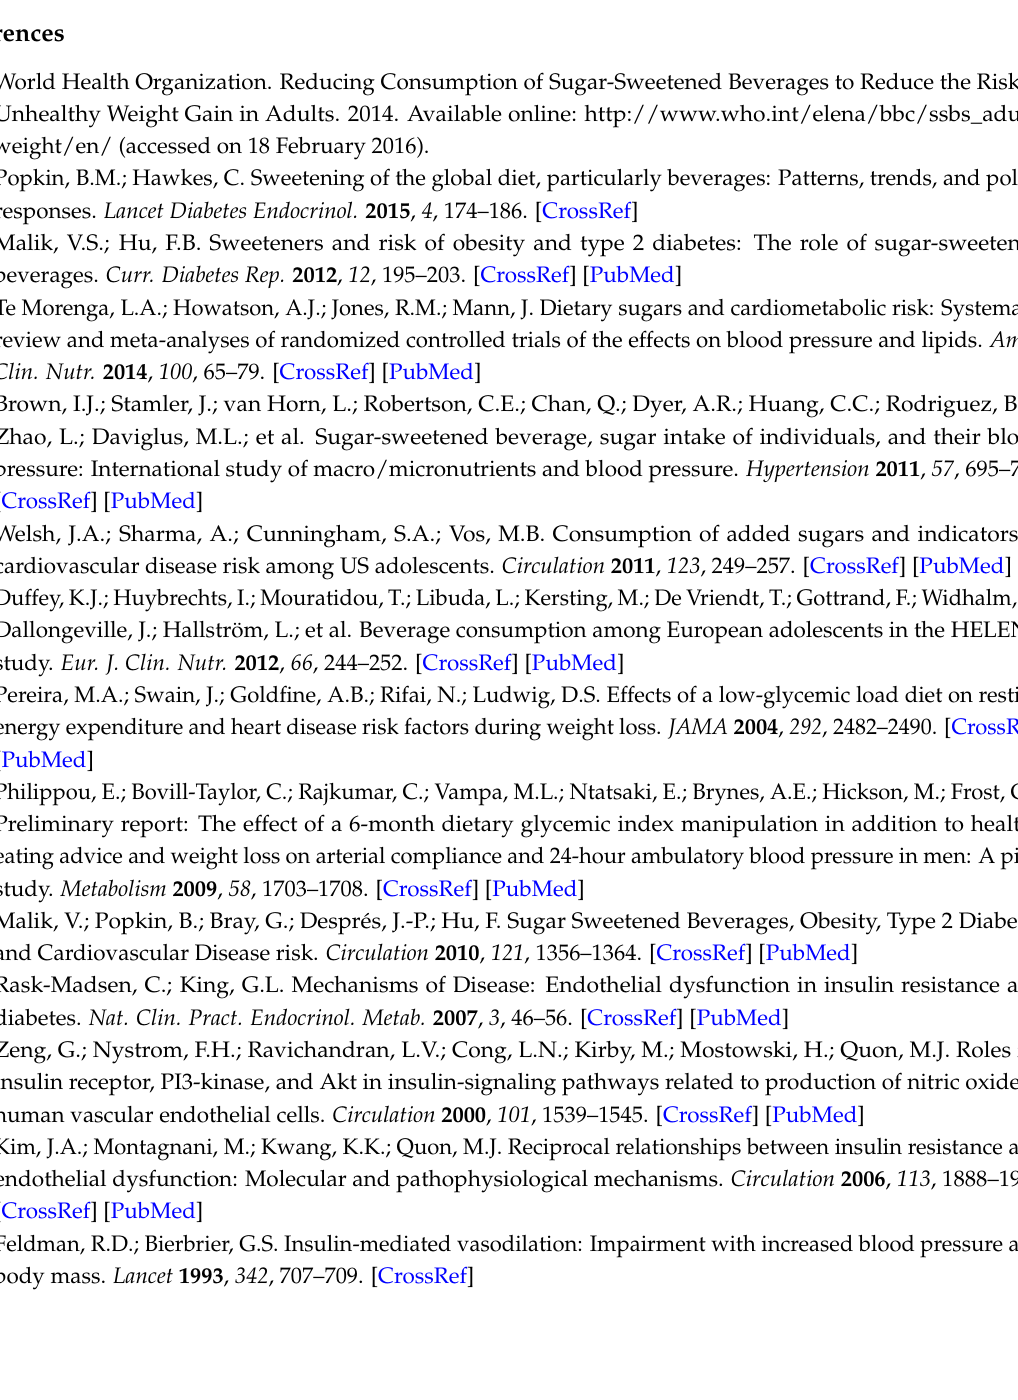
Table S1: Composition of the diet stratified by activity, low-GI and high-GI intervention. Acknowledgments: Isomaltulose (Palatinose™) was kindly provided by Beneo GmbH (Mannheim, Germany) free of